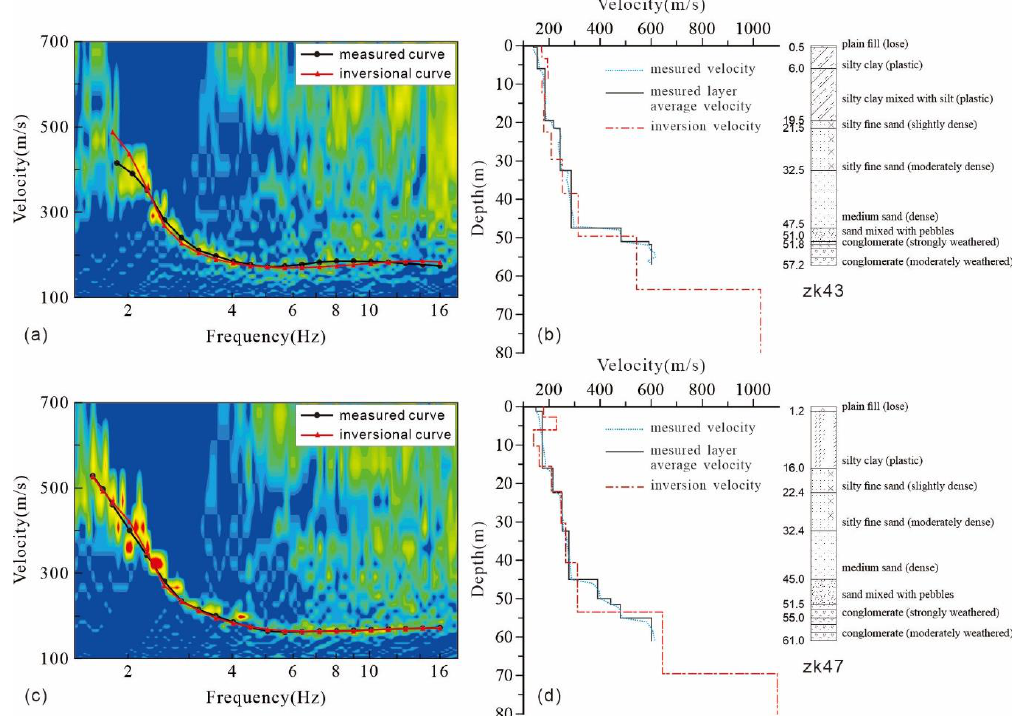
Figure 4. Dispersion curves and inversion results of microtremor exploration points in study area I. ( a ) dispersion curves of H32; ( b ) inversion model of H32 and in situ test results of zk43; ( c ) disper- sion curves of H110; and ( d ) inversion model of H110 and in situ test results of zk4.